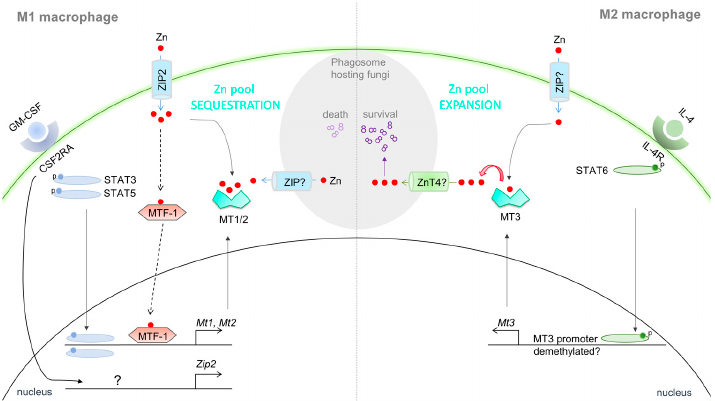
Figure 2. MTs shape the macrophage Zn pool and antifungal defenses. M1 macrophage (left side of center dotted line): GM-CSF binds to its receptor, CSF2RA, to trigger STAT3 and STAT5